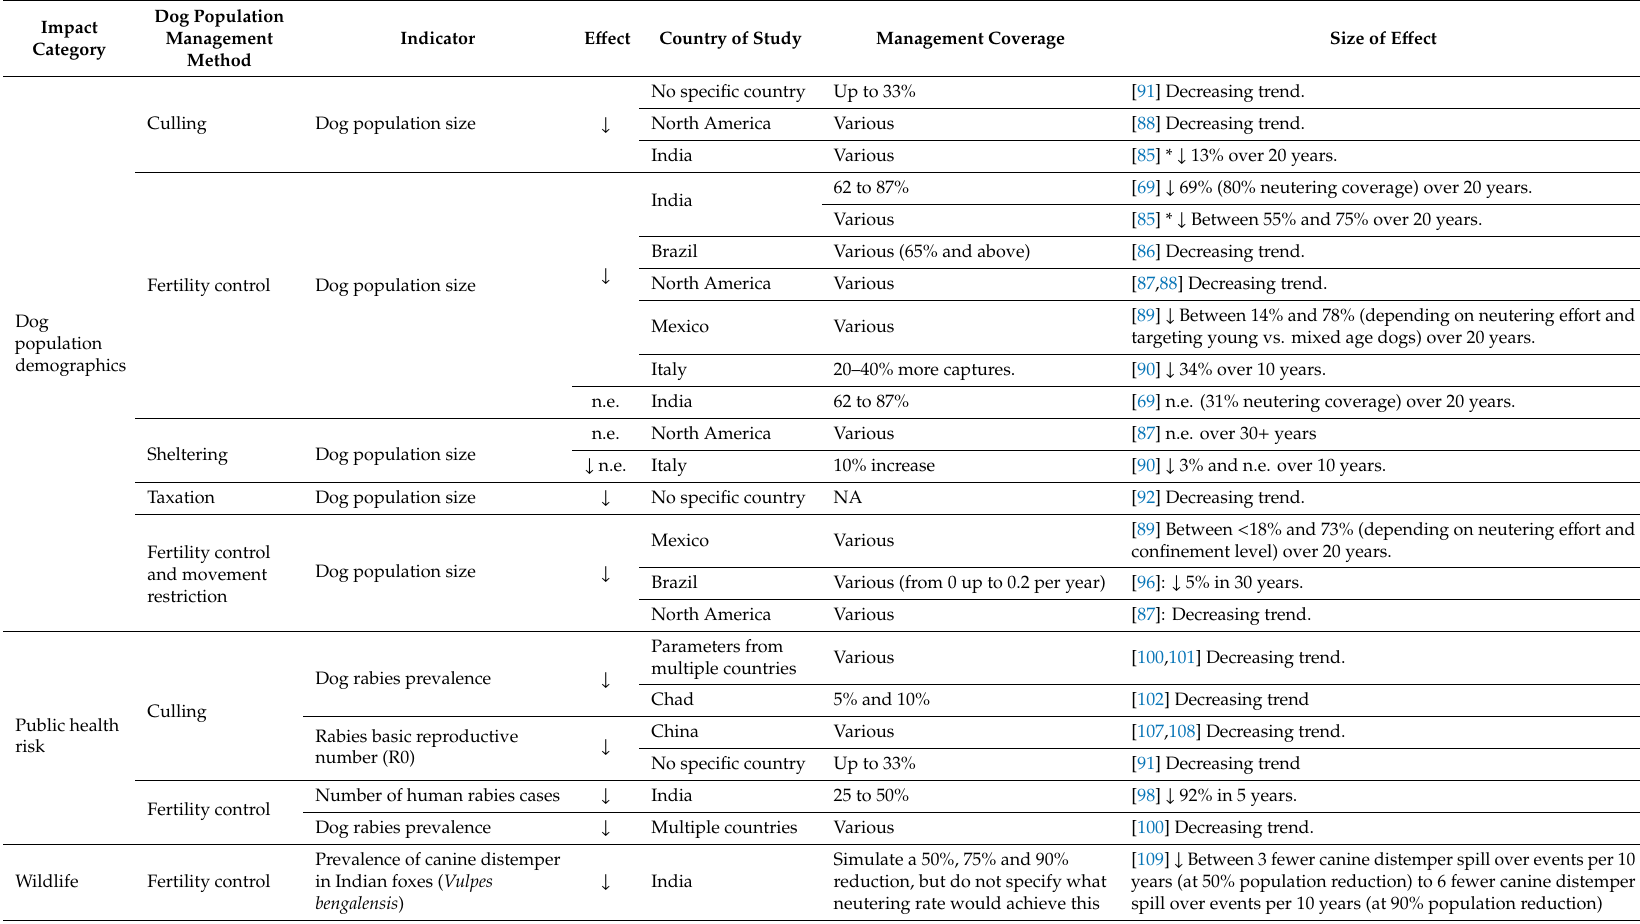
Table 4. Results from only modelling papers from the final corpus of the e ff ects of methods of dog population management on the indicators of impact and impact categories. ↑ indicates an increasing e ff ect, ↓ a decreasing e ff ect, and n.e. no e ff ect; combinations of di ff erent symbols indicate where evidence is conflicting. The size of e ff ect is extracted from papers and reported in terms of the years of modelling simulation. Supporting evidence is provided in